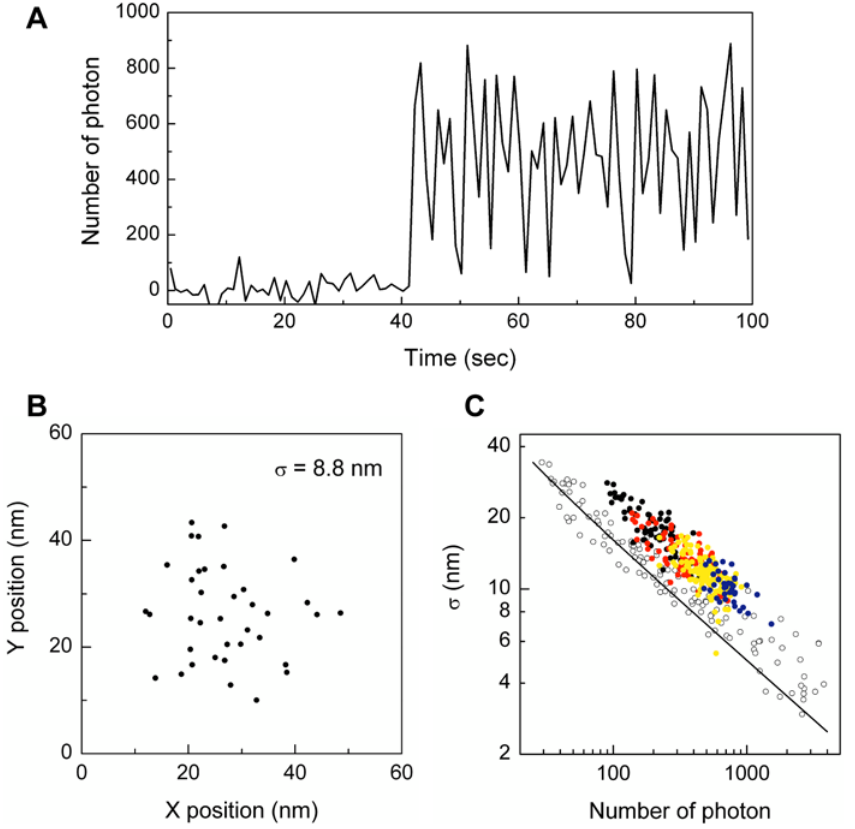
Figure 7. Localization accuracy obtained from mKikGR molecules. (A) Fluorescence intensity trajectory of a single mKikGR molecule. The trajectory was constructed from single-molecule images of the red mKikGR (100 ms integration, 1 Hz). (B) Centroid positions obtained from single- molecule images of the red mKikGR. (C) Relationship between the localization accuracy and the total number of photons obtained from individual red mKikGR molecules (circle). The images were recorded with 568 nm excitation at the power of 13 (black circle), 33 (red circle), 65 (yellow circle), and 130 (blue circle) W cm 2 2 . The open circle shows the relationship between the localization accuracy and the total number of photons obtained from individual qdots. The solid line shows theoretically calculated localization accuracy using equation